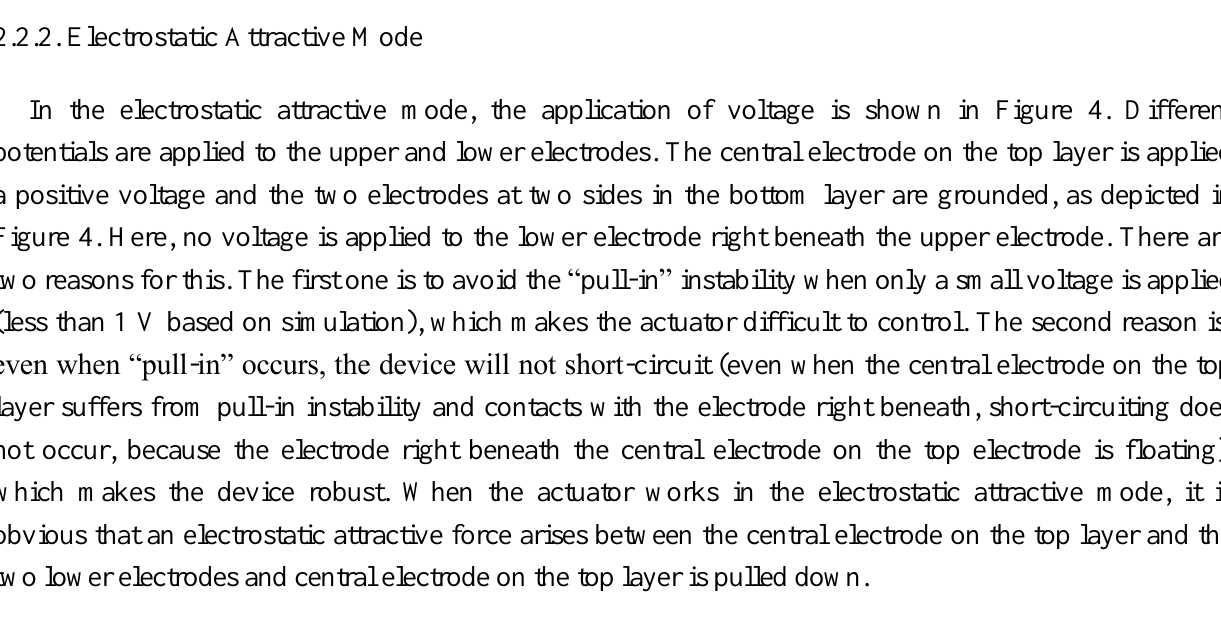
Figure 4. Schematic of the electrostatic attractive mode (cross-sectional view, only the three pairs of electrode in the center is shown); here “V” indicates the application of a positive voltage to this electrode, “GND” means application of ground, and N/A indicates electrode